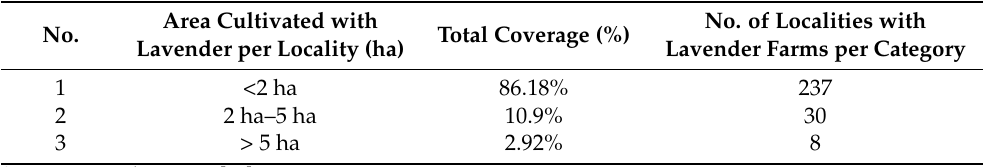
Table 1. Lavender farms in